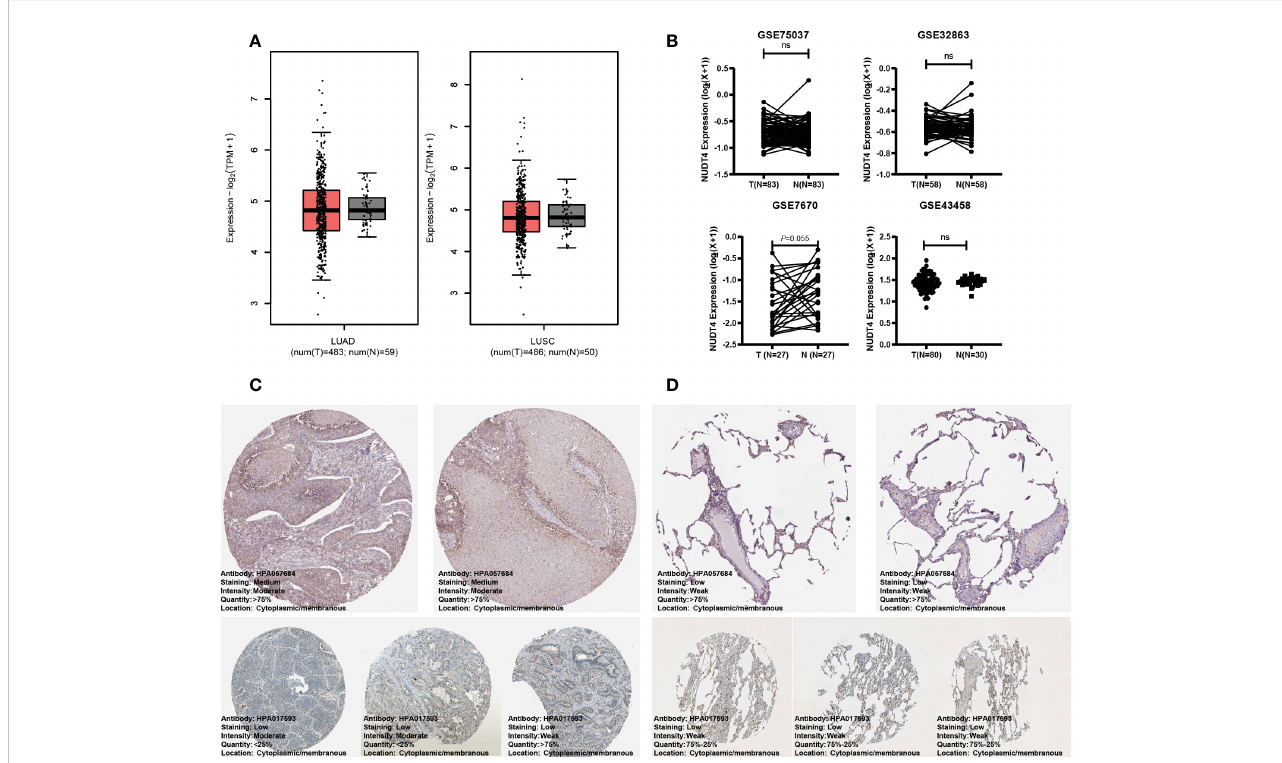
FIGURE 7 NUDT4 expression in bulk RNA level and protein level. (A) NUDT4 expression in lung adenocarcinoma and squamous carcinoma in TCGA datasets. (B) NUDT4 expression in lung adenocarcinoma in GEO datasets. (C) The protein level of NUDT4 in lung adenocarcinoma chips using immunochemistry. (D) The protein level of NUDT4 in normal lung tissue chips using immunochemistry. LUAD: Lung adenocarcinoma; LUSC: Lung squamous cell carcinoma; ns: Not statistically signi fi